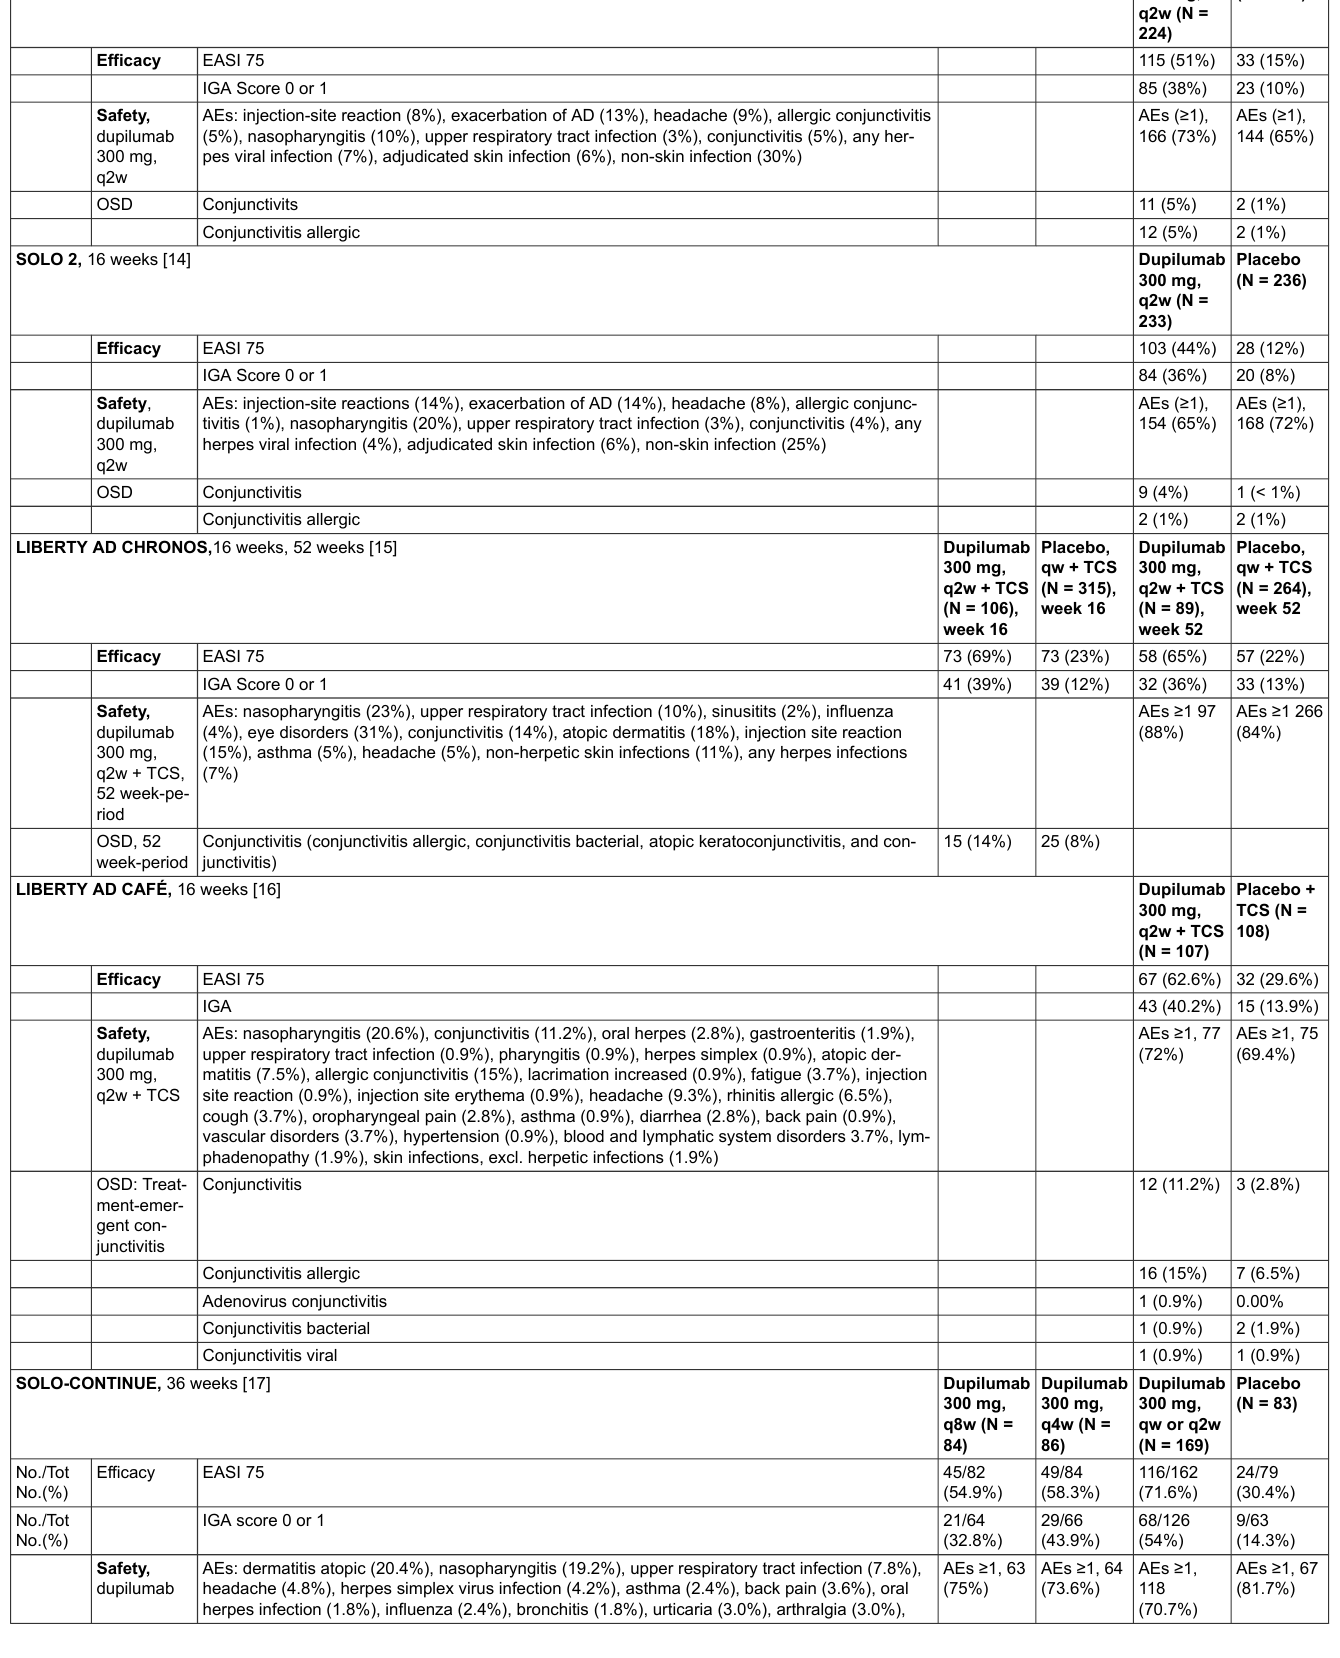
Placebo 300 mg, (N = 224) q2w (N = 224)